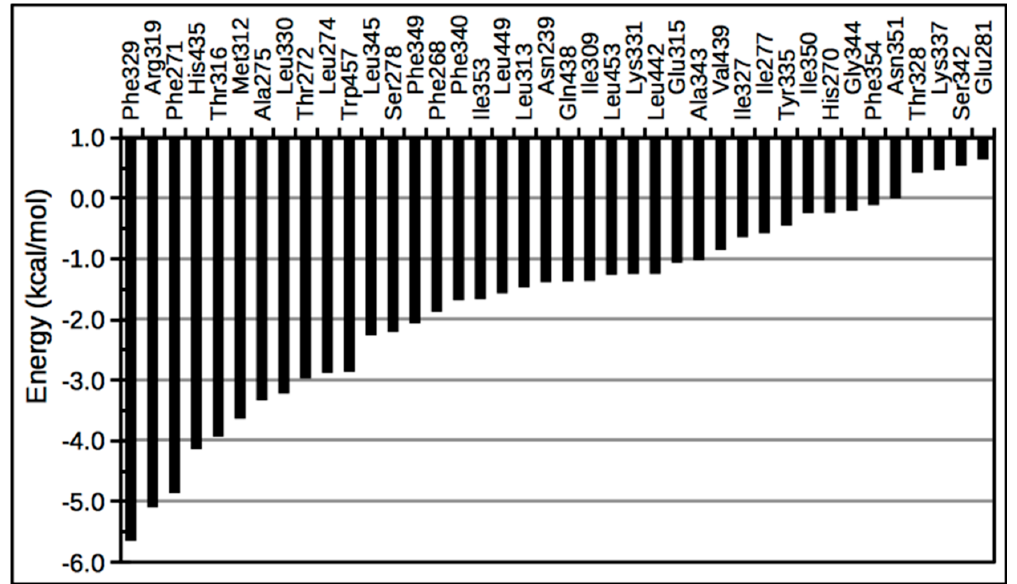
Figure 11. Pairwise interaction energies of 40 amino acids with ligand within the LXR β binding pocket.